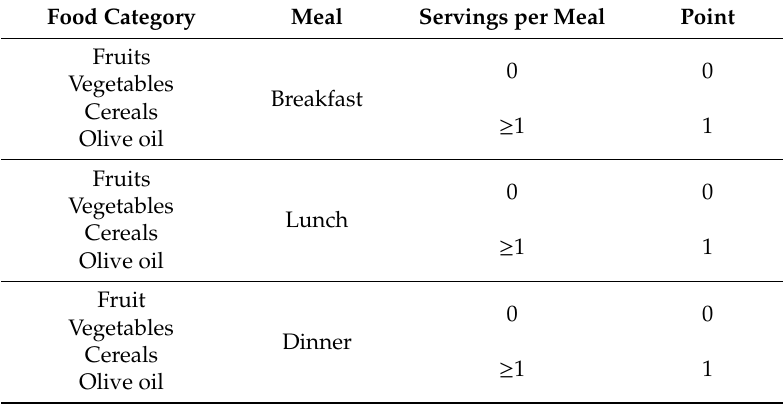
Table A1. Scoring of food groups counted on a meal basis Food Category